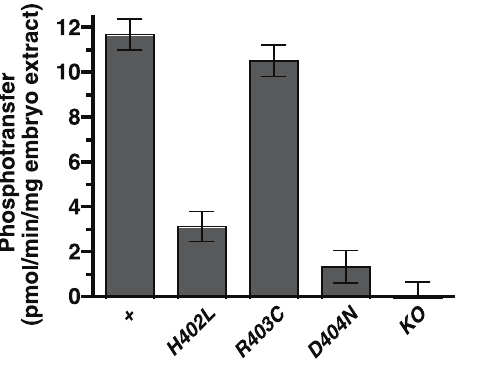
Figure 4. Tyrosine kinase activities of src64 HRD mutants. Phosphotransfer was measured in cellularization-stage embryo extracts. Src64-dependent phosphotransfer to a peptide substrate is shown. src64 H402L , src64 D404N and src64 KO differ from wild type (p , 0.01). Wild type, src64 H402L and src64 R403C differ from src64 KO (p , 0.01). Error bars are